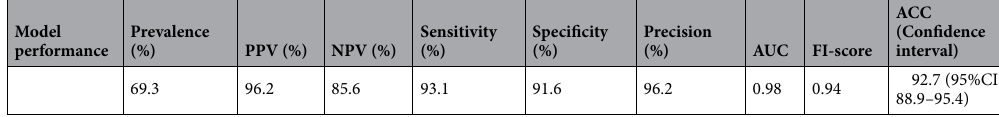
Table 4. Performance metrics of random forest predictive model of HBsAg response.